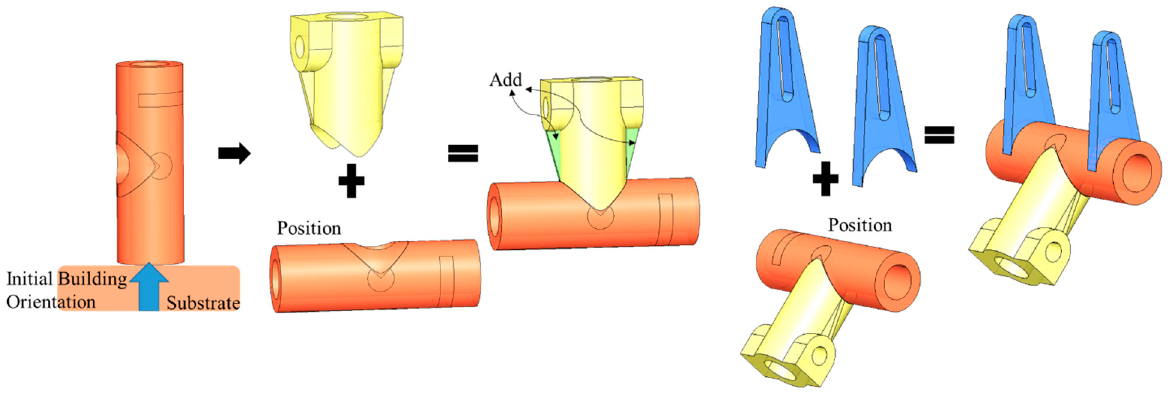
Figure 16. Process Planning with second defined initial building orientation for model (b). The accumulated trajectories for this geometry, including the added volumes, are shown in Figure 17.